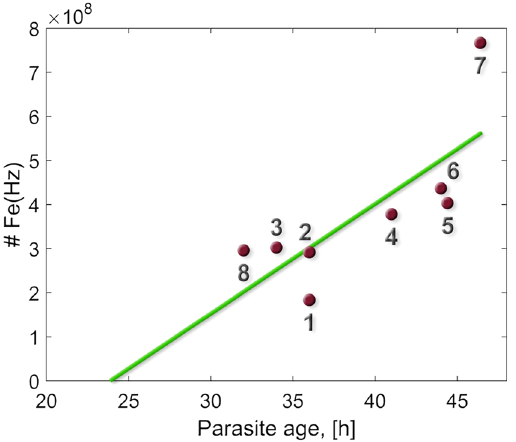
Figure 5. Hemozoin iron content as a function of the parasite age in parasites 1–8. Blue circles are the measured values taken from Table 1, and the green line is the fit with equal weights. The slope of the best fitting line yields the estimated rate of in vivo crystallization, and the x intercept the estimated onset time for heme